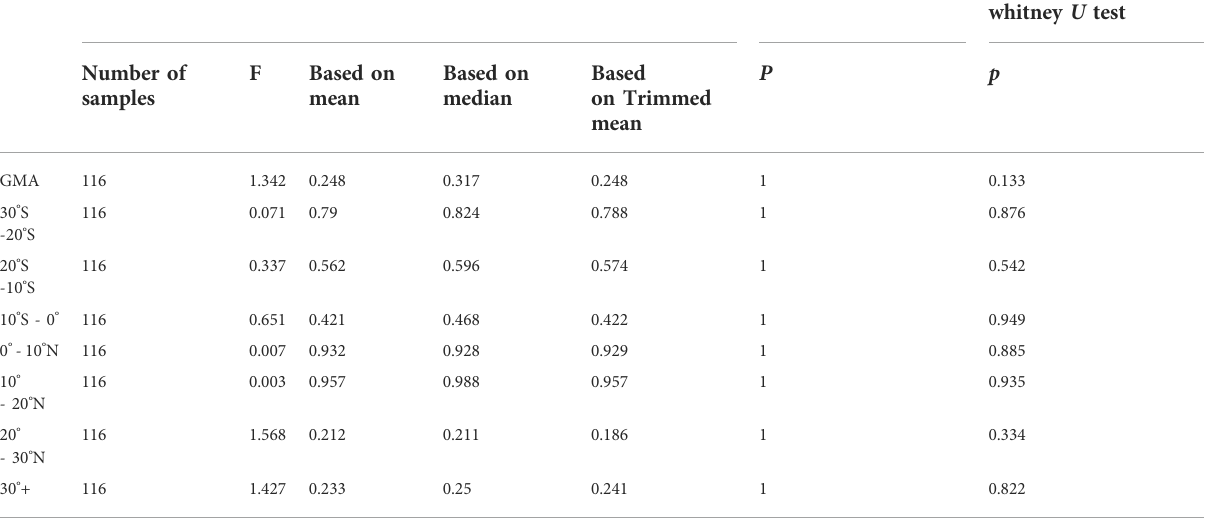
TABLE 4 The independent sample test between reconstructions and instrumental values.